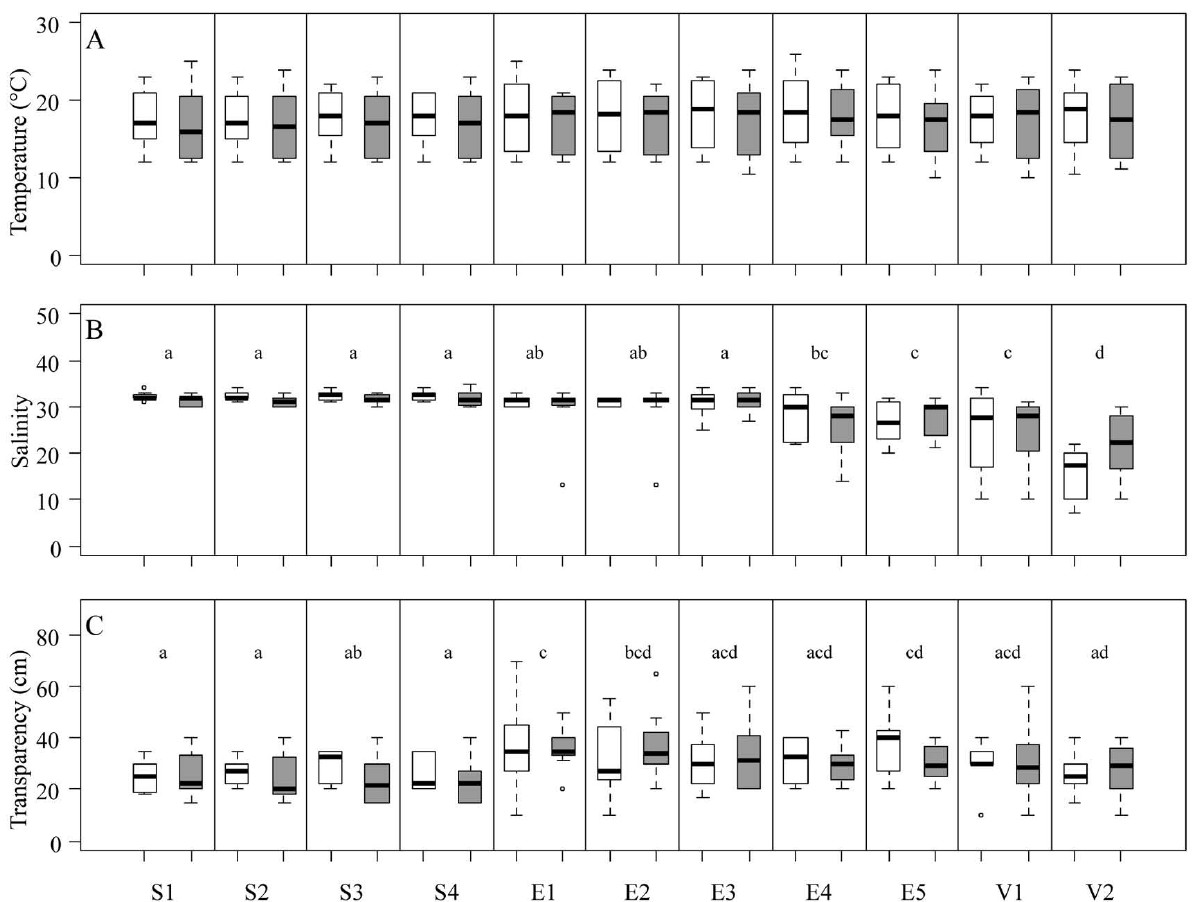
Fig. 2. – Spatial variation in water temperature (A), water salinity (B) and water transparency (C) (Secchi depth) along the marine-estuarine gradient in Mar Chiquita coastal lagoon at ebb (white boxes) and flood (grey boxes) (line, median; box, 25th to 75th percentiles; whiskers, minimum to maximum value range). Different letters denote significant differences between sampling stations without considering tidal